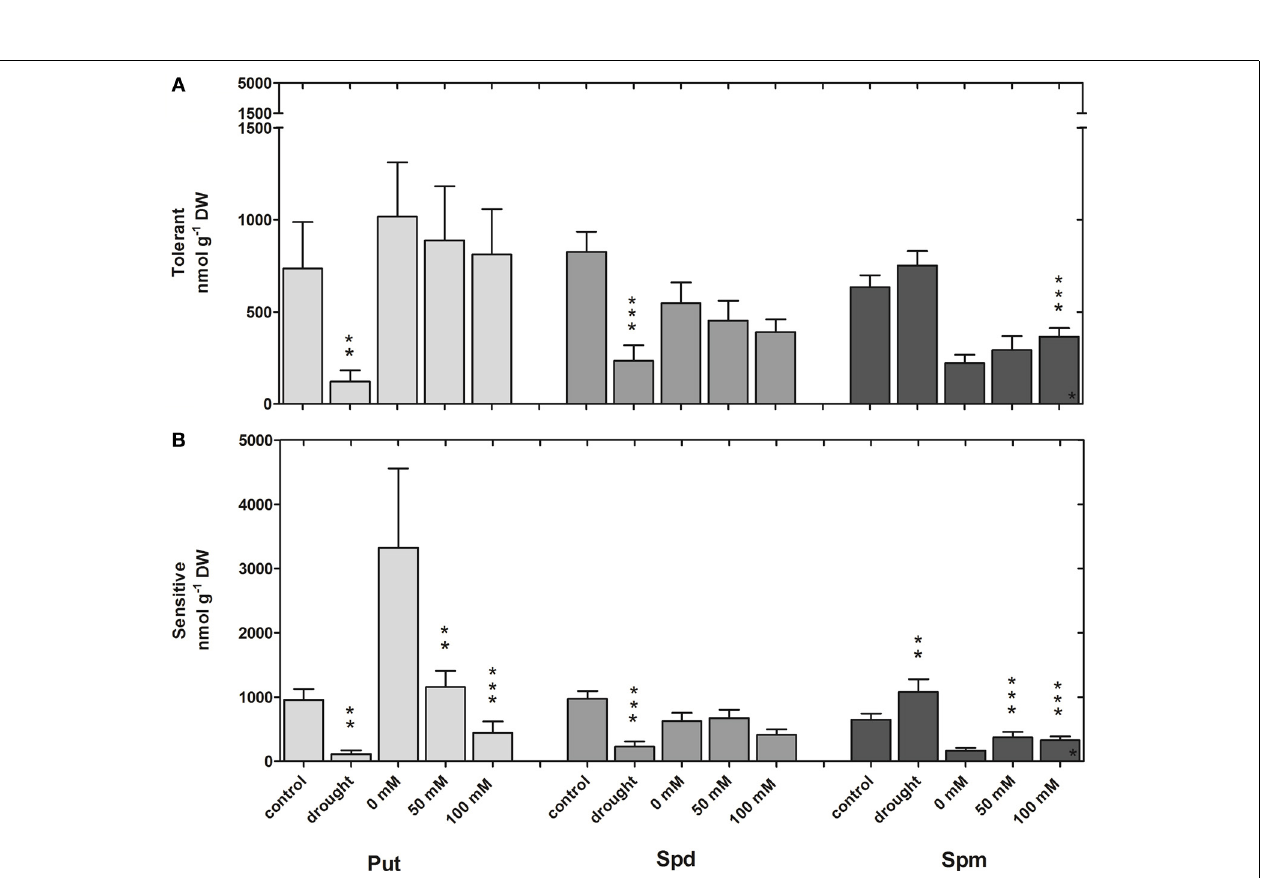
FIGURE 5 | Log 2 fold change of expression of genes, encoding enzymes involved in polyamine biosynthesis, under salt stress (50, 100mM) as compared to control conditions in eight rice cultivars differing in salt